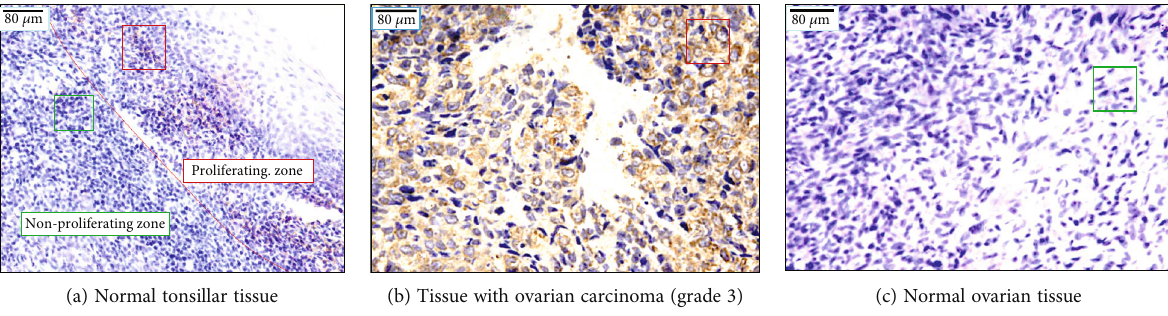
Figure 5: TK1 IHC staining of hTK1-IgY-rmAb#5: (a) TK1 staining of normal tonsil tissue; (b) a patient with ovarian serous adenocarcinoma (grade 3). TK1 staining is observed in brownish-yellow, mainly in the cytoplasm (examples of TK1 in the red box). (c) Normal ovarian tissue was taken from the far outside of the total ovarian serous adenocarcinoma specimen as a standard control (normal spindle cells are shown in green box). Blue staining was used to counterstain nuclei with haematoxylin. Magni fi cation